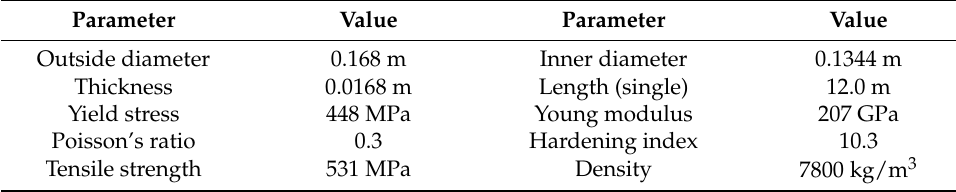
Table 1. Material properties and geometric parameters of pipeline.